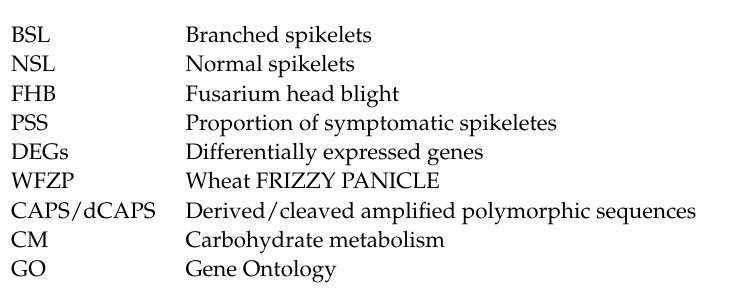
Table S3: Clean reads quality metrics, Table S4: 2540 DEGs between the BSL and NSL plants, Table S5: Differentially expressed transcripts between the BSL and NSL plants, Table S6: Significantly enriched KEGG pathways in the BSL plants, Table S7: Significantly enriched molecular function in the BSL plants, Table S8: Significantly enriched cellular components in the BSL plants, Table S9: Significantly enriched biological processes in the BSL plants, Table S10: Function annotation and expression of 20 key DEGs in five representative